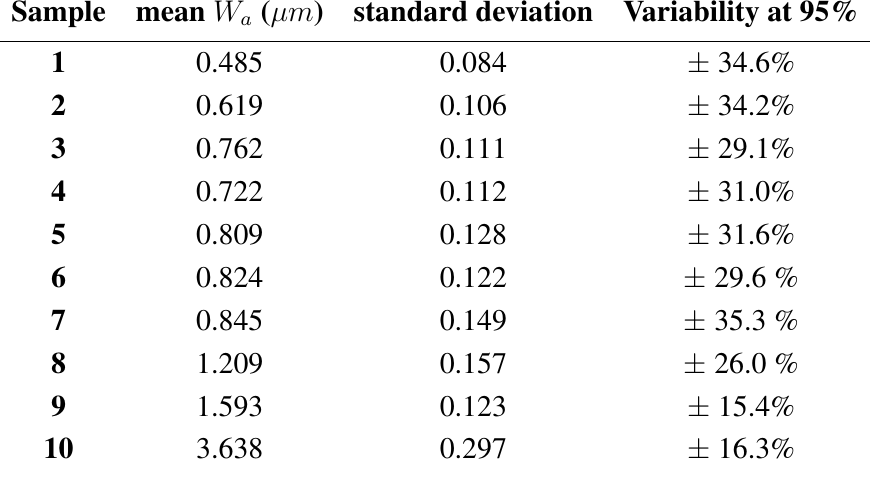
Table 1. Variability of the W parameter when calculated over different profiles for each a sample with a cutoff wavelength of 0.25